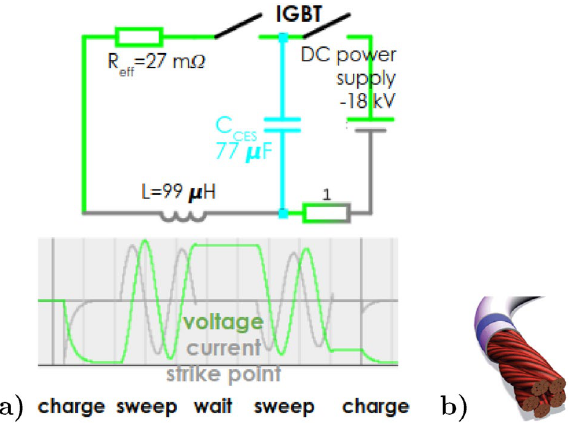
Figure 3. ( a ) Oscillation circuit of the swept coil. The current I coil (directly proportional to the strike point position) oscillates during 2 subsequent ELMs. Charging after each even ELM suppresses the coil mechanical vibrations down to 0.1 mm due to heavy coil inertia (explained in Section 5 in 43 ). ( b ) Sketch of 45 mm thick Litz conductor sustaining of twisted 0.25 mm thin wires without isolation. Such a cable suppresses the skin-effect, passing thus 1 kHz AC currents with resistivity near its DC value. Let a cooling pipe be located in the central empty